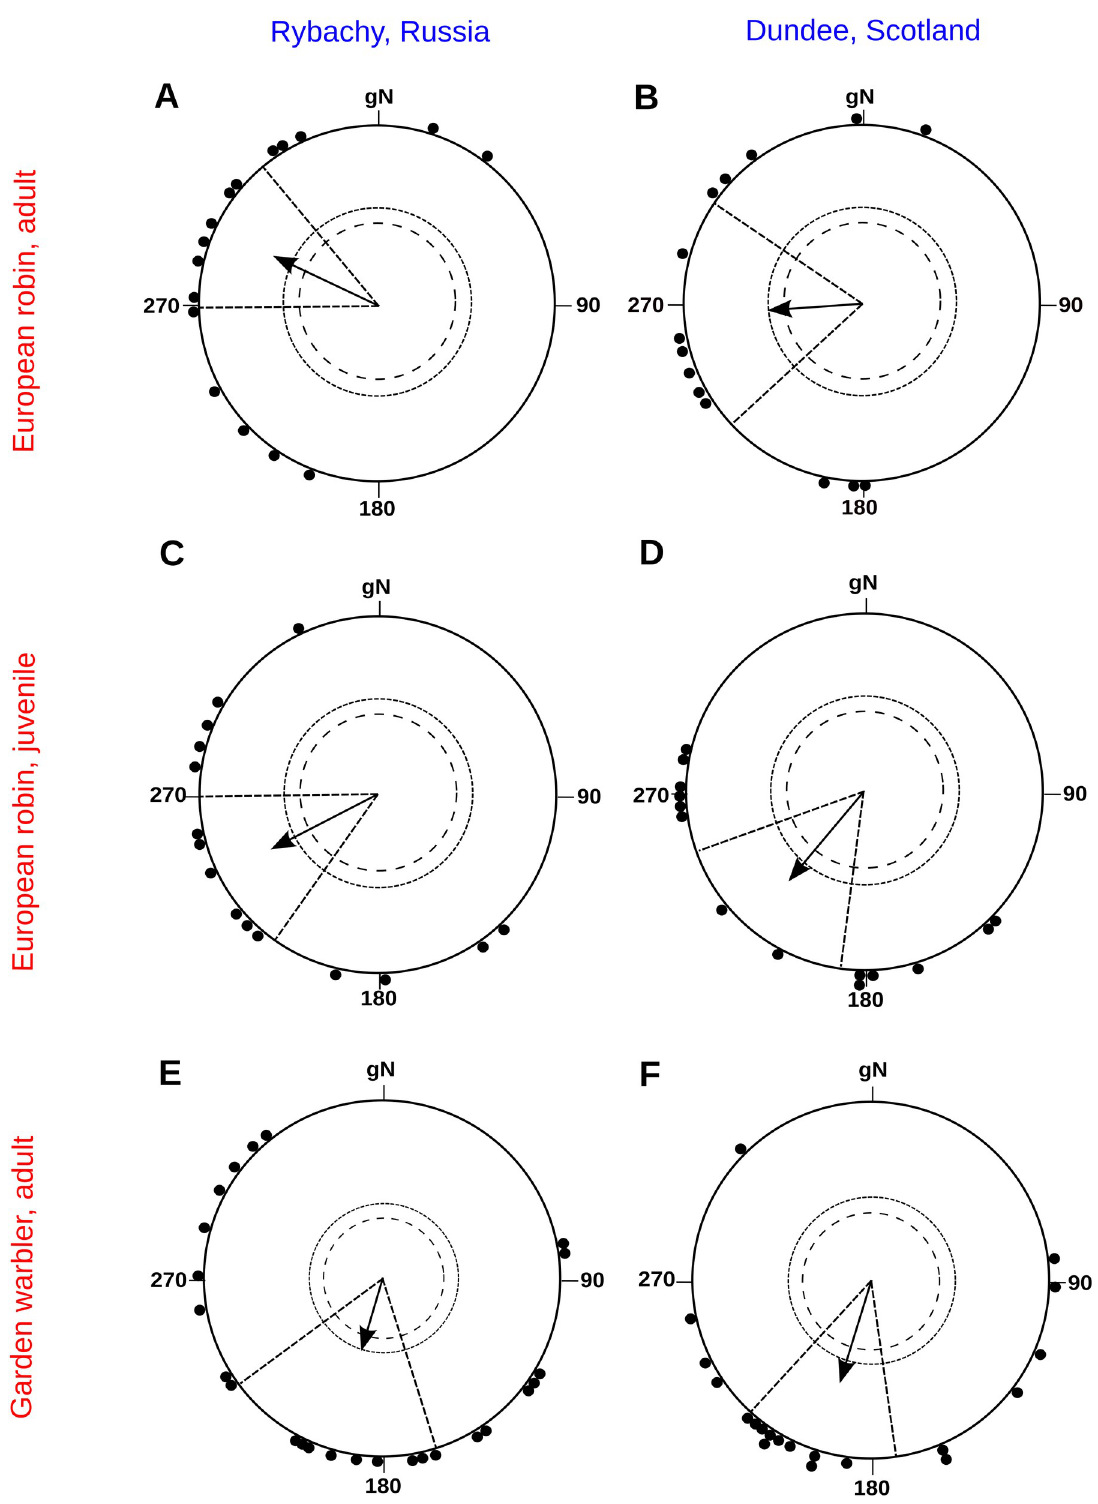
Fig 1. Orientation of adult European robins (a, b), juvenile European robins (c, d) and adult garden warblers (e, f) tested during autumn migration on the Courish Spit before (in the natural magnetic field of Rybachy, left column) and after virtual magnetic displacement (in the magnetic field of Scotland, right column). Each triangle at the circle periphery indicates the mean orientation of one individual bird;